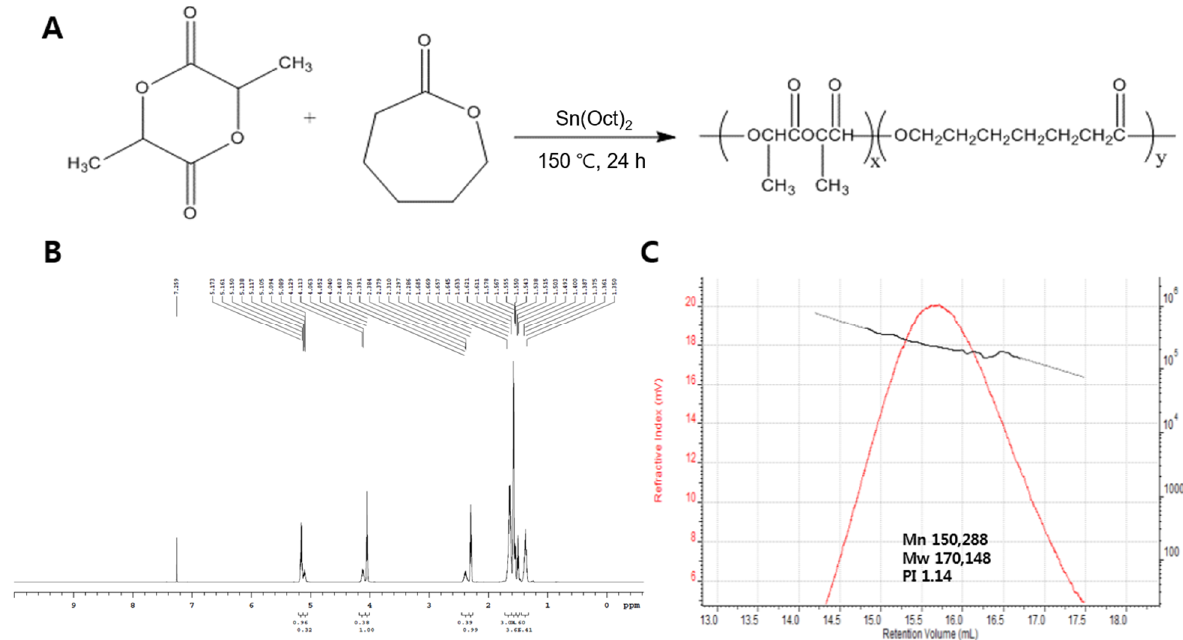
Figure 2. PLCL synthesis and characterization. ( A ) Scheme for the PLCL copolymer synthesis. ( B ) 600 MHz 1 H-NMR spectrum of the PLCL copolymer (50:50). ( C ) Gel permeation chromatography (GPC) curve of the PLCL copolymer.